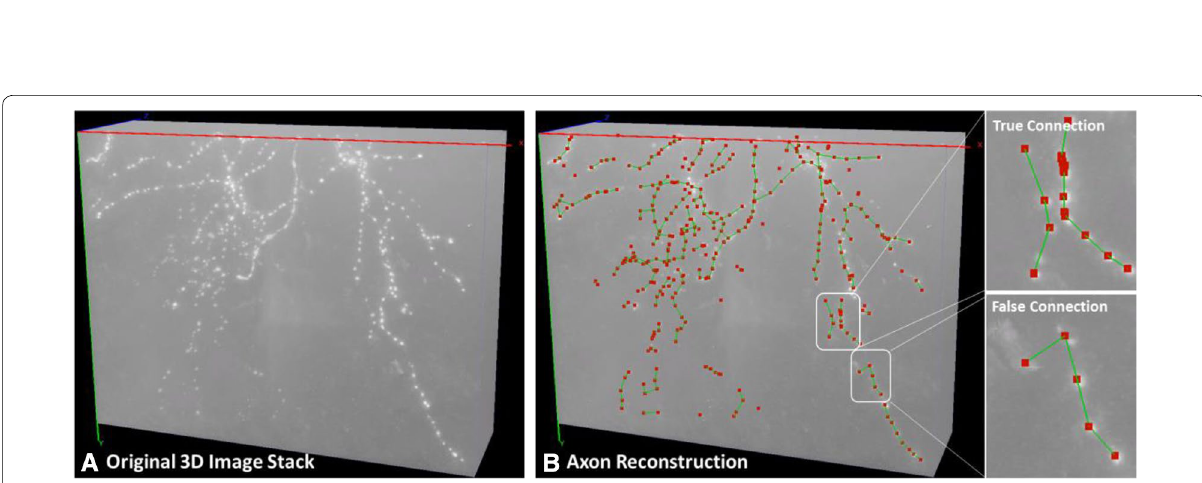
Fig. 5 DeepNeuron axon reconstruction. ( a ) The same example image as shown in Fig. 2a. ( b ) 3D axon signals (red dots) were extracted with neurite signal detection module; local 3D connections (green lines) between signals were generated by neurite connection module. As shown in B, the proposed DMST in the connection module can formulate the correct neurite structure even when the detected signals from different neurites are spatially close to one another. In a more difficult case, however, the loss of true signal in the local area can make the information captured by the network outweighed by the distance, resulting in false connection. This could be avoided by adequately enlarging the examined local area. Note that unconnected fragments like those on the bottom left would be further processed by our non‑deep‑learning functions of the tool, which is